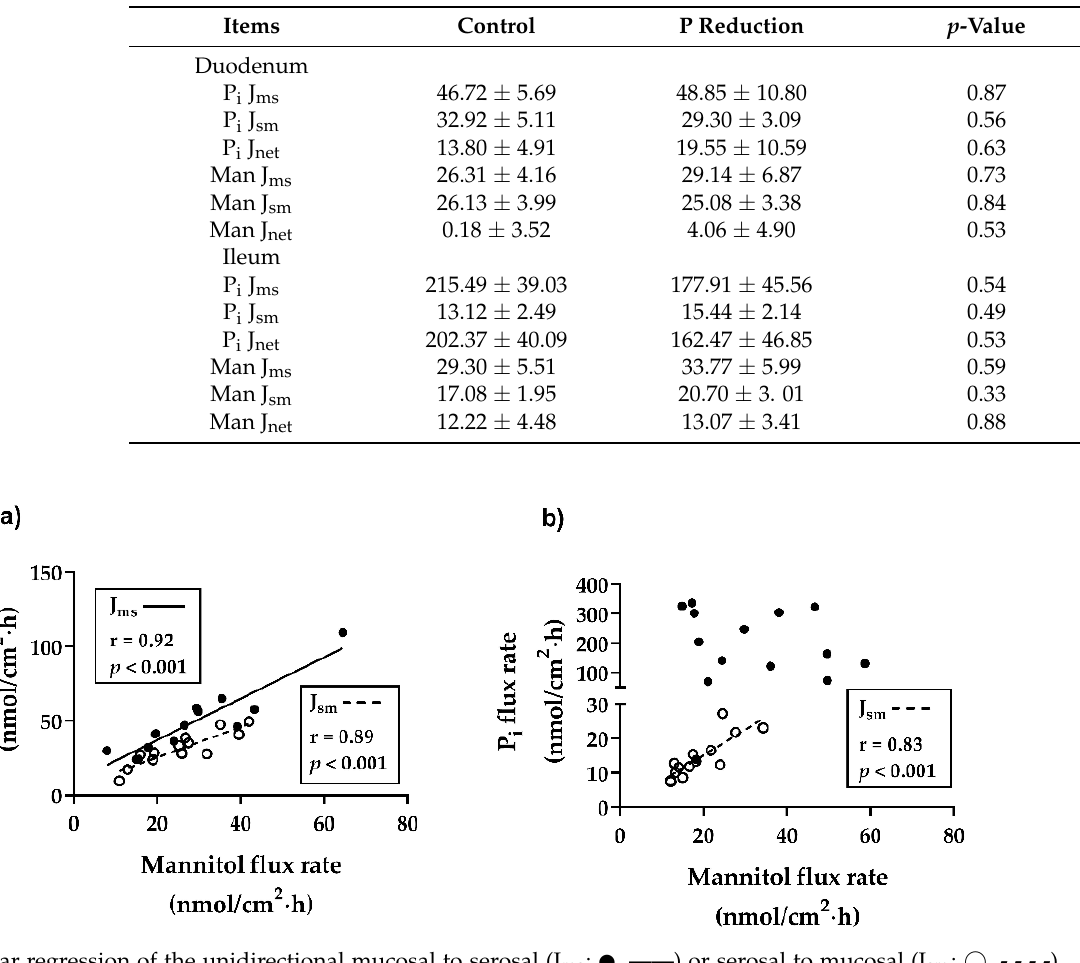
Figure 1. Linear regression of the unidirectional mucosal to serosal (J ms ; ⚫ , ─── ) or serosal to mucosal (J sm ; ⚪ , - - - - ) flux rates of inorganic phosphate (P i ) with the corresponding mannitol flux rates in duodenum ( a ) (J ms P i = (1.39 ± 0.17), J ms mannitol = (9.19 ± 5.33); J sm P i = (1.02 ± 0.15), J sm mannitol = (4.88 ± 4.21)) and ileum ( b ) (J ms P i = −(1.40 ± 2.10), J ms mannitol = (240.9 ± 72.56), r = 0.189, p = 0.5163; J sm P i = (0.74 ± 0.14), J sm mannitol = (0.28 ± 2.87)) from goats fed different phosphorus supply.